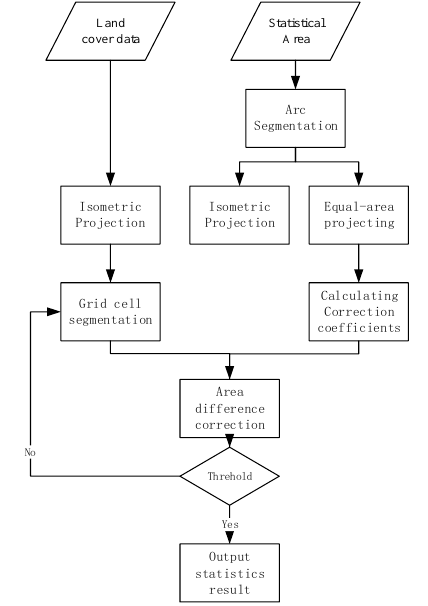
Figure 7. Flowchart of the developed strategy to correct